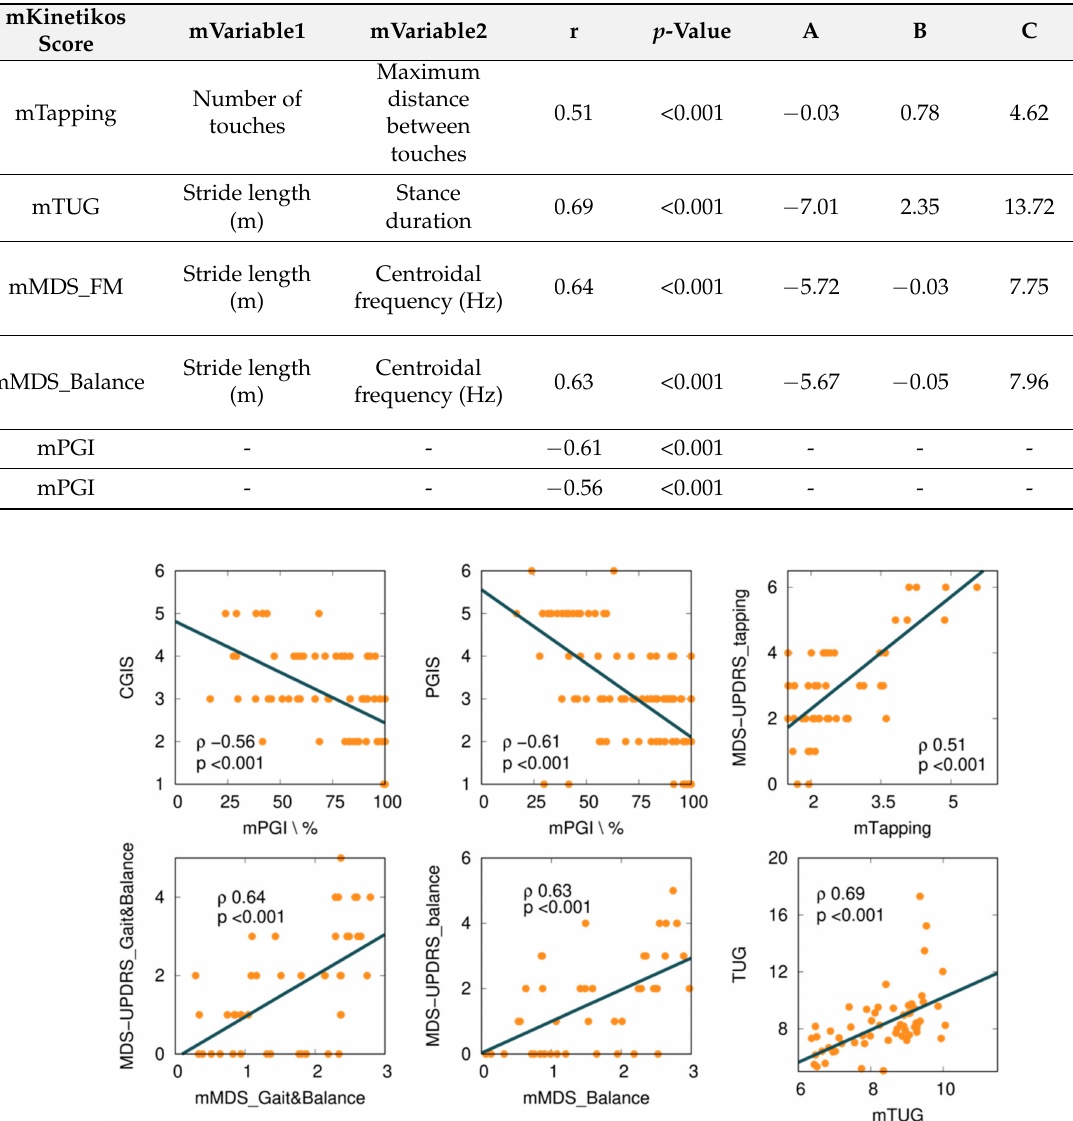
Table 5. Correlation between clinical and mKinetikos scores.